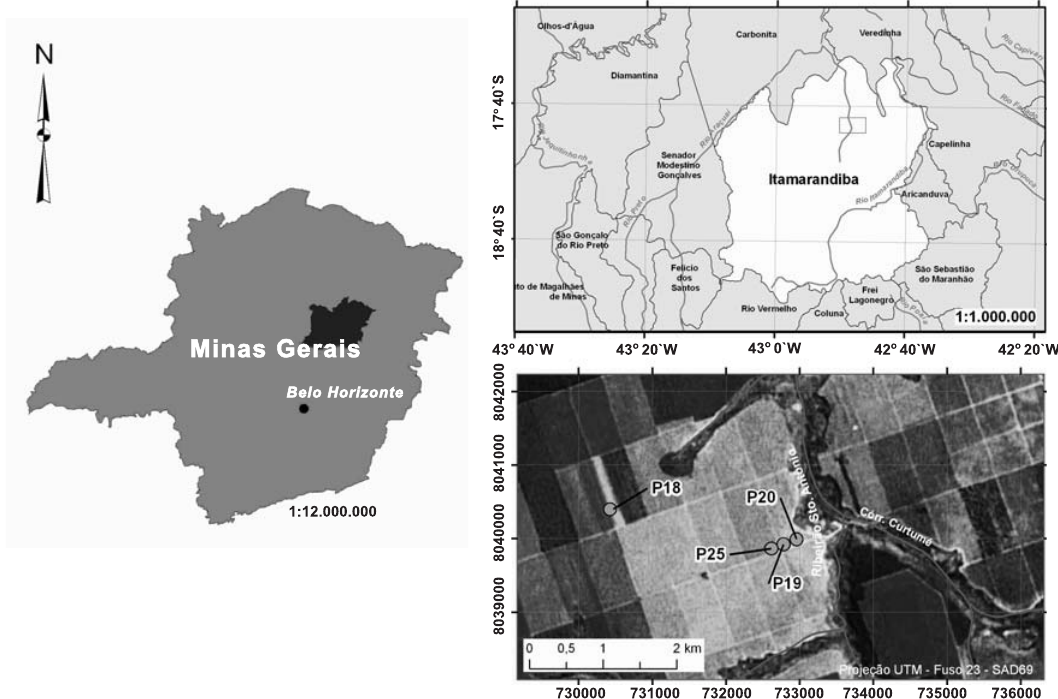
Figure 1. Location of the toposequence, LV (P18), LVA (P25), LA (P19) and "LAC"